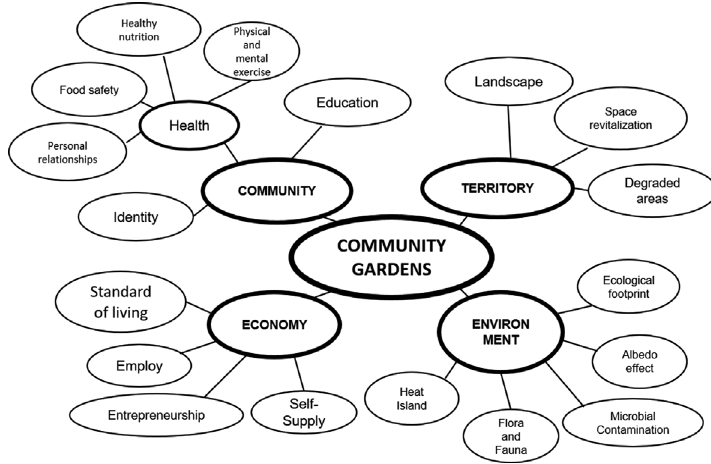
Fig. 2. Multifunctionality of community gardens. Source: own